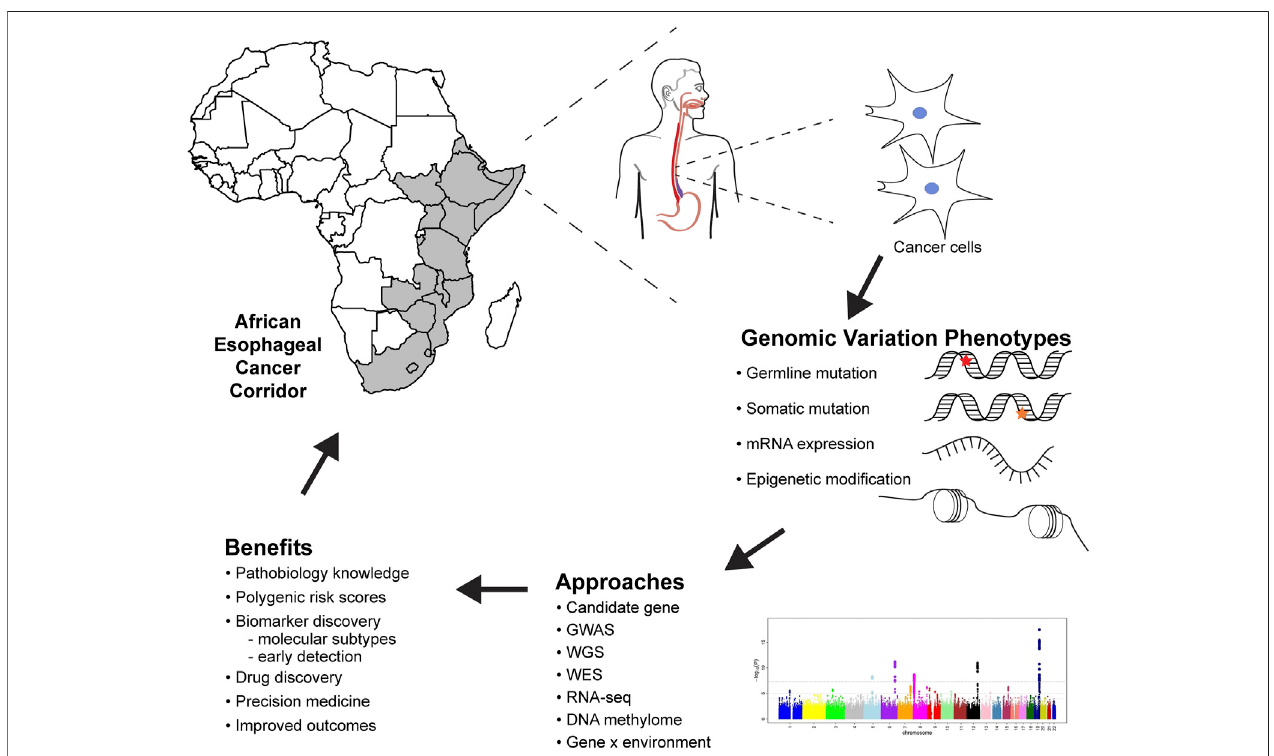
FIGURE 1 | Future of esophageal squamous cell carcinoma genomic research in Africa, methods, analysis, and bene fi ts to genomic medicine. GWAS, genome- wide association studies; WGS, whole-genome sequencing; WES, whole-exome sequencing; RNA-seq, RNA sequencing.